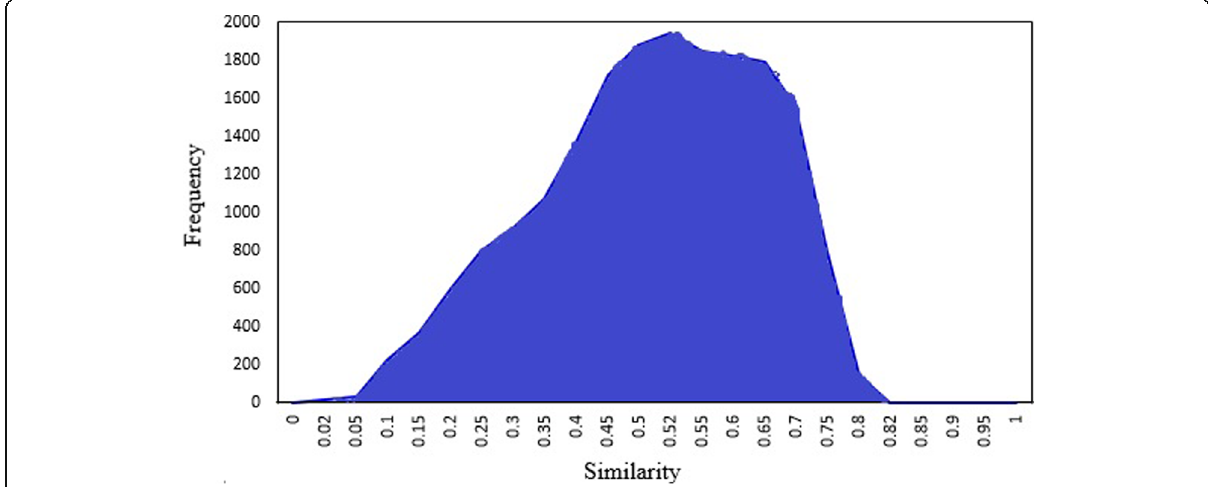
Fig. 6 Distribution of similarities between hashes of different